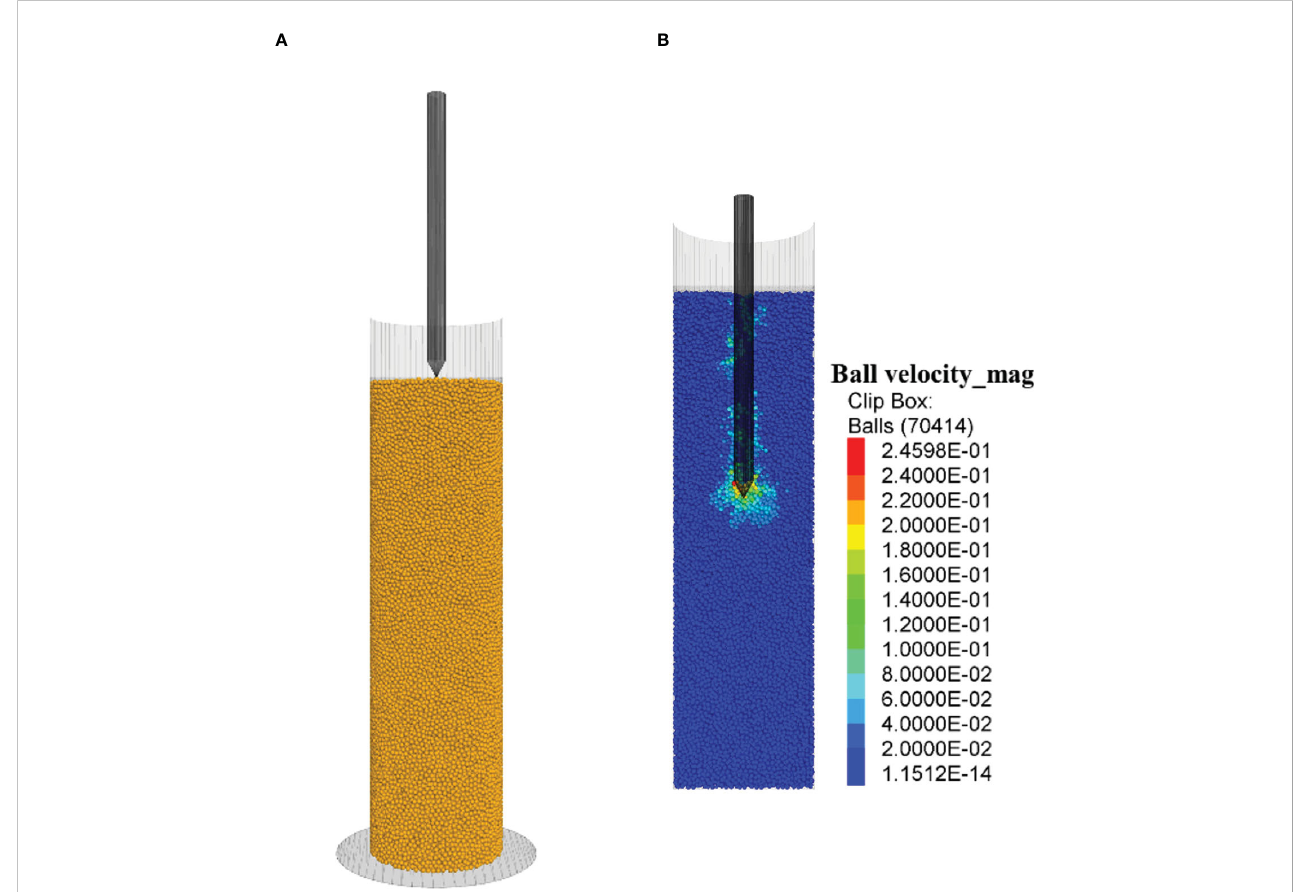
FIGURE 5 Virtual soil penetration tests. (A) Initial position of the micro-penetrometer probe and soil particles. (B) Soil particle velocity countours, while the probe penetrating the soil.